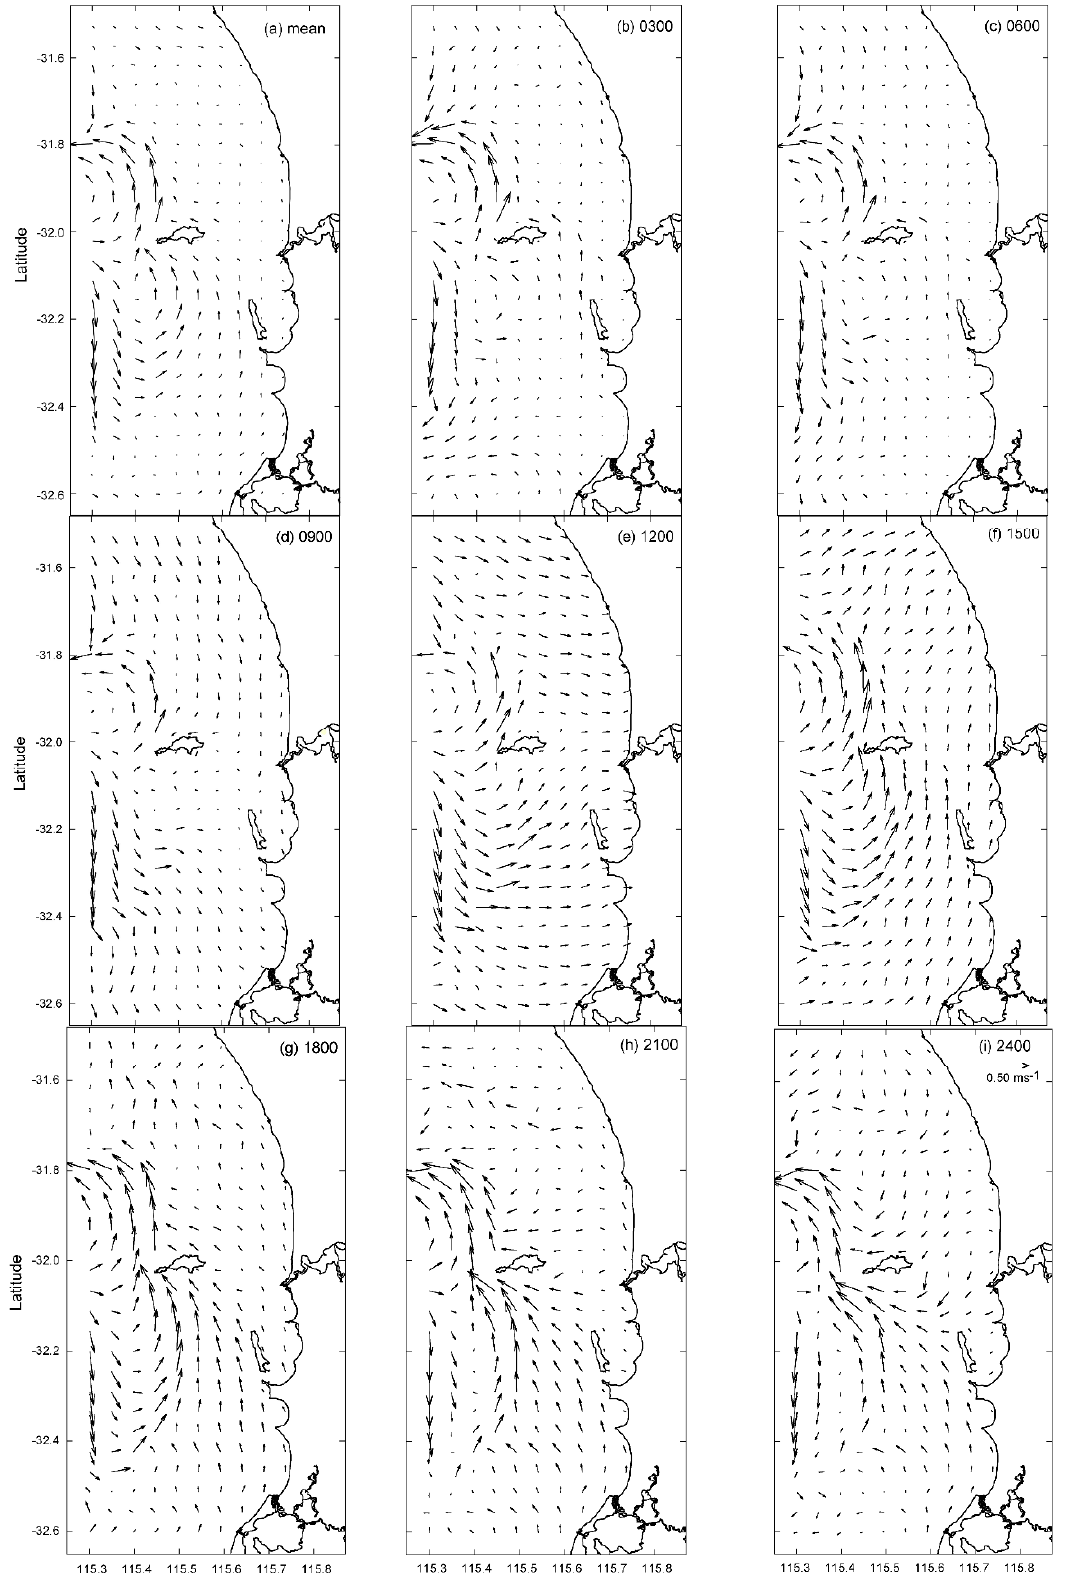
Figure 14. Surface ocean currents in the study region over a diurnal cycle on 8 December 2016 from the ROMS model. ( a ) mean over 24 h; and ( b – i ) current vectors at 3 hourly intervals. Note the velocity scale for all plots are shown on ( i ).